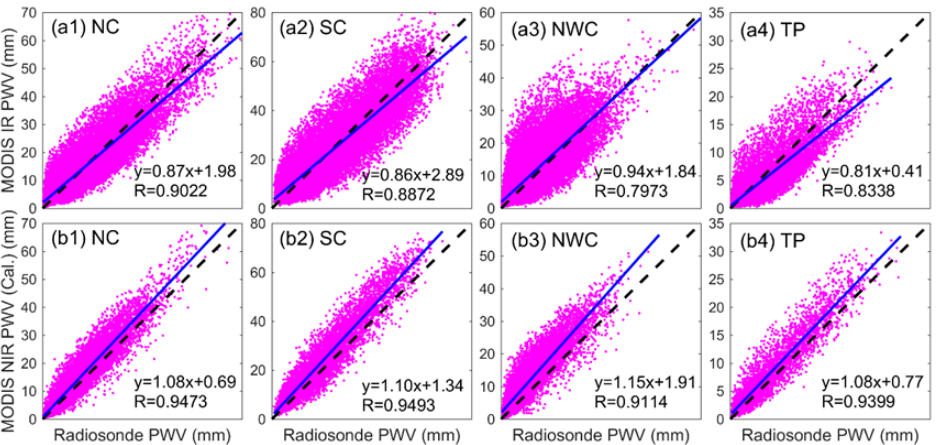
Figure 2. Scatterplots of the radiosonde-derived versus MODIS-derived IR/NIR PWV values over the period of 2000 – 2010 in the four areas in China, where ( a1 – a4 ) are the comparison of MODIS IR and radiosonde PWV, and ( b1 – b4 ) are the comparison of MODIS NIR and radiosonde